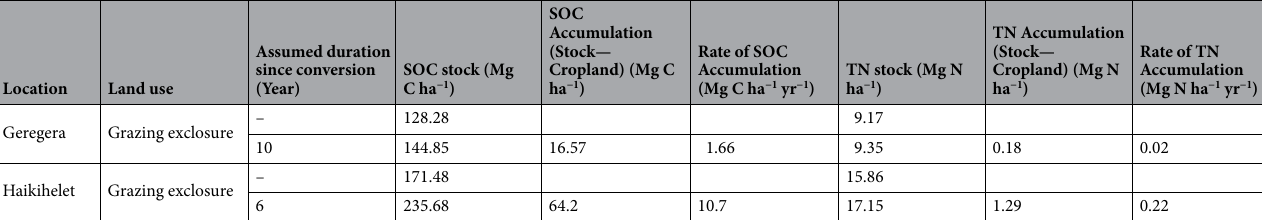
tively (Table 3). The estimated total loss of SOC resulting from forest conversion to cropland led to SOC loss of 9.04 Mg ha −1 yr −1 and 2.05 Mg ha −1 yr −1 in Desa’a and Hugumburda respectively. Also, conversion of forest to grazing land accounted for a total SOC loss of 3.50 Mg ha −1 yr −1 and 0.61 Mg ha −1 yr −1 in Desa’a and Hugum- burda, respectively (Table 4). Similarly, forest conversion to cropland gave rise to emission of 33.16 Mg ha −1 yr −1 CO 2 and 7.52 Mg ha −1 yr −1 CO 2 in Desa’a and Hugumburda, respectively (Table 4). More so, the conversion of forest to grazing land accounted for an emission of 12.84 Mg ha −1 yr −1 CO 2 and 2.21 Mg ha −1 yr −1 CO 2 in Desa’a and Hugumburda respectively. Regarding TN loss, forest conversion to cropland accounted for a TN loss of 0.99 Mg ha −1 yr −1 and 0.12 Mg ha −1 yr −1 in Desa’a and Hugumburda respectively. More so, conversion of forest to grazing land accounted for very low TN loss in Desa’a and Hugumburda (Table 4). In Desa’a and Hugumburda, conversion of forest to grazing land and cropland accounted for huge SOC stock depletion amounting to 30 to 50% of the SOC in the topsoil layer. Forest conversion to grazing land in Desa’a resulted to a reduction in total SOC and TN stock of 3.50 Mg C ha −1 yr −1 and 0.36 Mg N ha −1 yr −1 in grazing land,